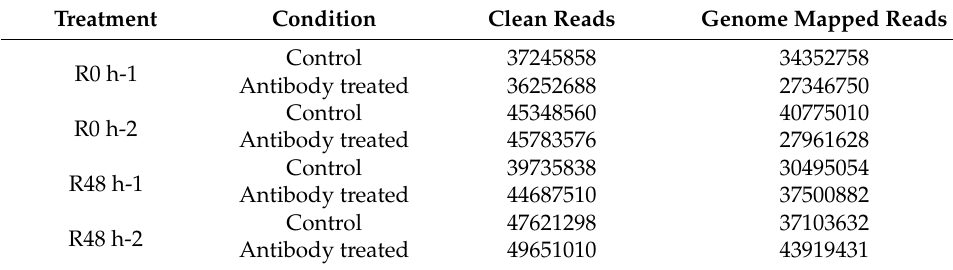
Table 1. Summary of ChIP-seq reads from eight different libraries.